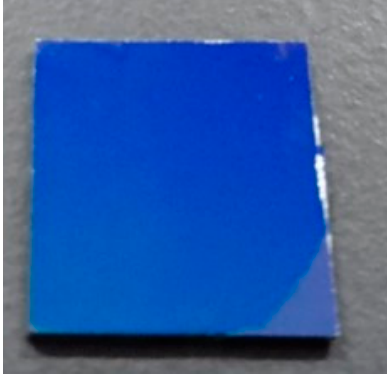
Figure 2. Photo image of ADS P3HT film on SiO 2 /Si.